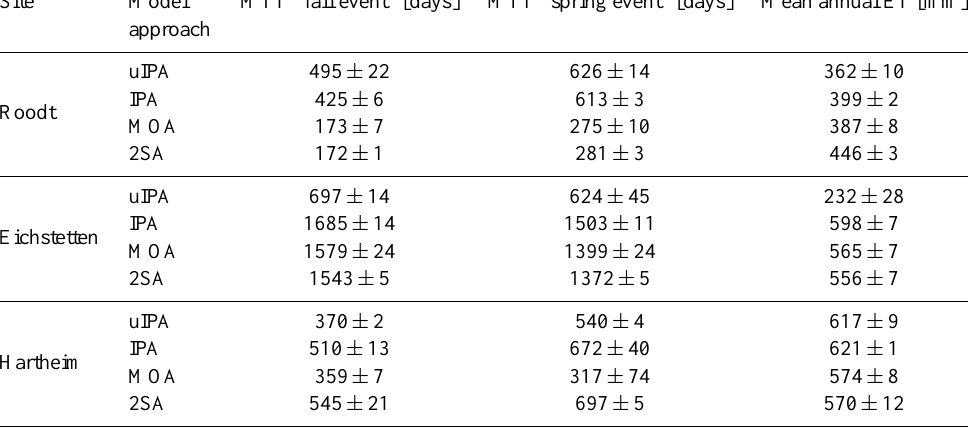
Table 5. The median transit time (MTT) of the two rain events in fall and spring, whose water was traced virtually through the vadose zone and the modelled average annual evapotranspiration (ET). The values are results for the best-performing parameter set and the given ranges are the standard deviation of the randomly sampled 100 parameter combinations of the set S best